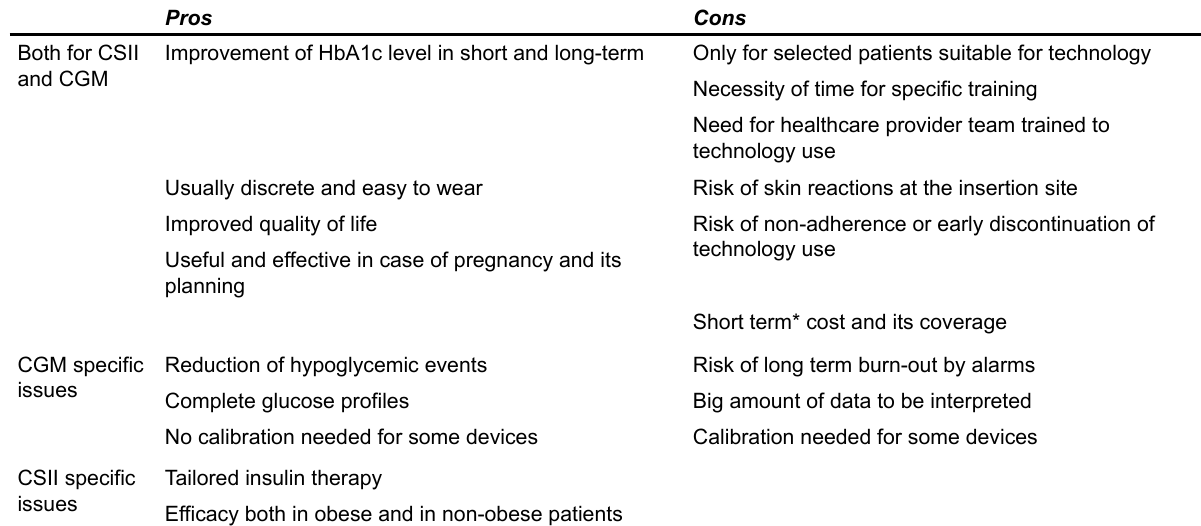
Table 3. Pros and cons of CSII and CGM technology among subjects with T2D Pros Cons Both for CSII and